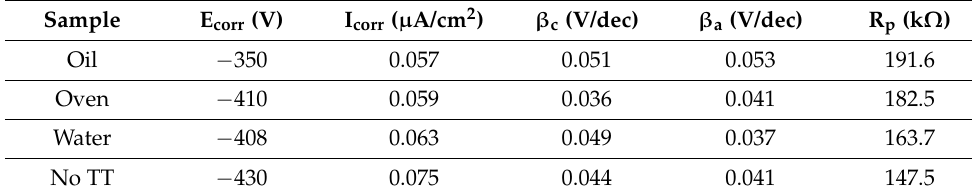
Figure 9. Polarization curves of the tested specimens. Table 3. Electrochemical parameters obtained by the Tafel extrapolation method from polarization curves.